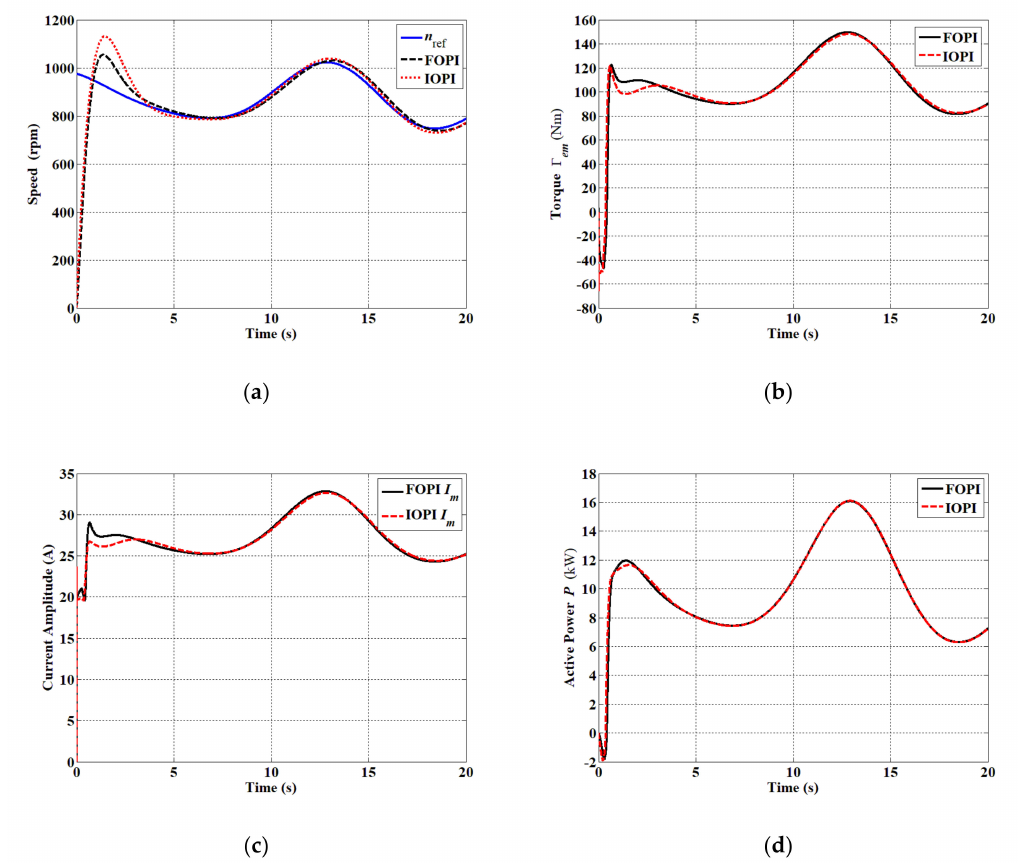
Figure 11. Performance of DFIG for FOPI and IOPI controllers with swell e ff ect: ( a ) DFIG speed; ( b ) electromagnetic torque; ( c ) rotor current amplitude; ( d ) active